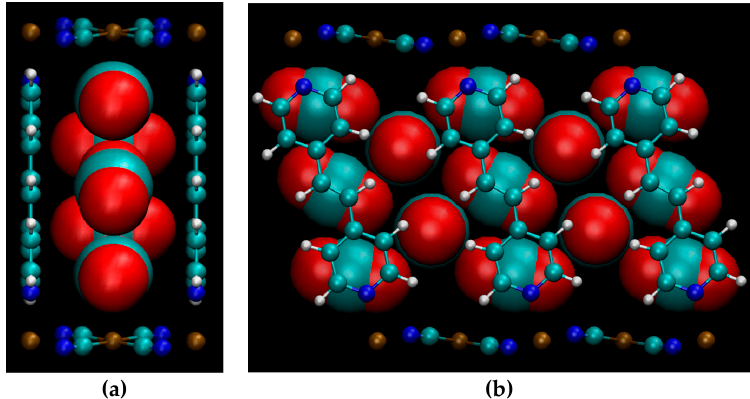
Figure 10. Predicted geometry of CO 2 at loading of five CO 2 per Bpene, projected along ( a ) the ab plane and ( b ) the ca plane. CO 2 molecules are magnified for clarity. Element key: gold = Ni, white = H, blue = N, green = C, red = O. Also see Figure 1.